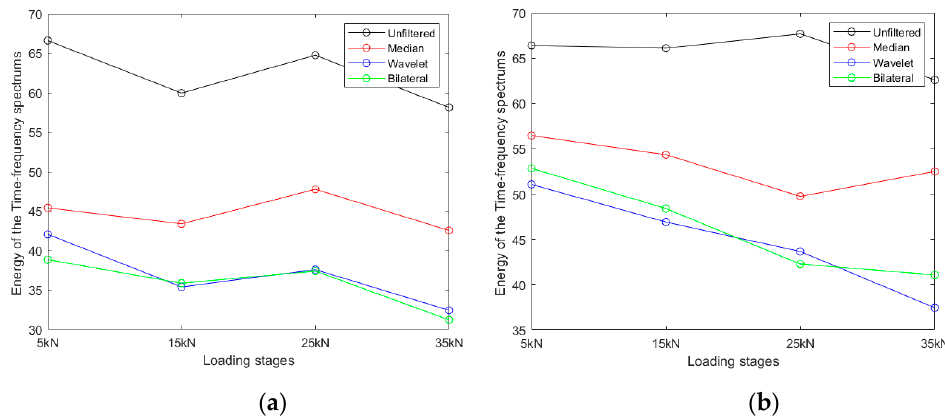
Figure 10. Time-frequency energy E for the different denoising approaches: ( a ) results for Accelerometer 1; ( b ) results for Accelerometer 2. 1; ( b ) results for Accelerometer